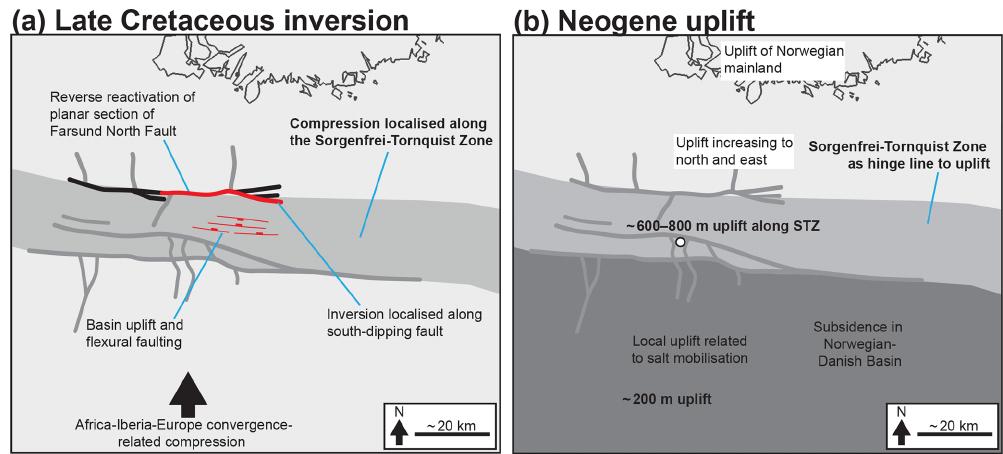
Figure 12. The different styles by which compressional stresses are expressed along the Sorgenfrei-Tornquist Zone throughout Late Creta- ceous and Neogene events. (a) The STZ localises compression originating from the south, at upper-crustal depths, this is buttressed against the Farsund North Fault via reverse reactivation and long-wavelength folding of hangingwall strata. (b) The STZ acts as a hinge line during the Neogene, separating areas of relatively low uplift in the Norwegian–Danish Basin, from the areas of relatively high uplift further north towards the Norwegian